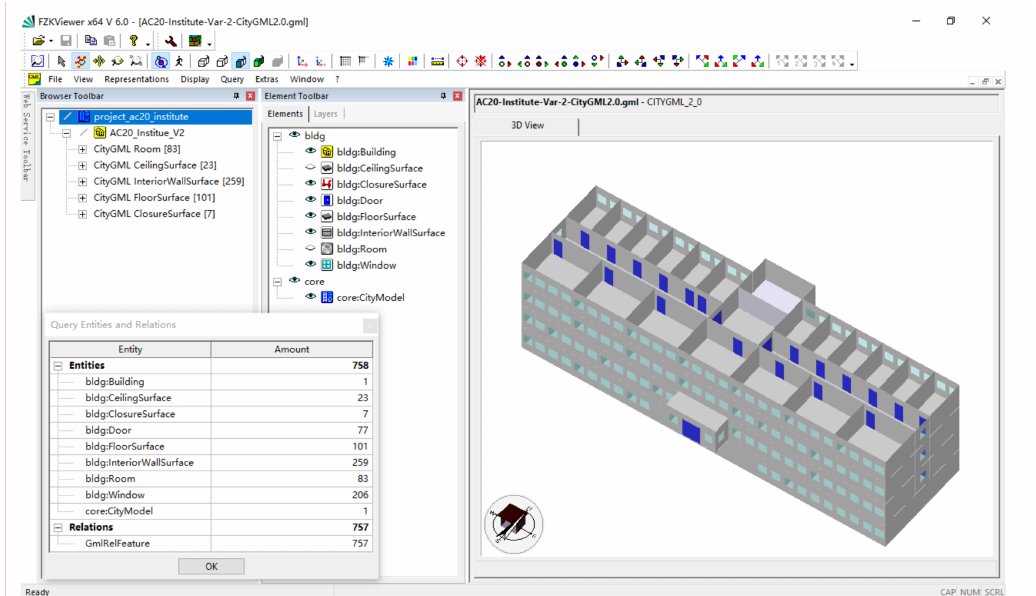
Figure 24. Extracted CityGML dataset based on 3DSISM.